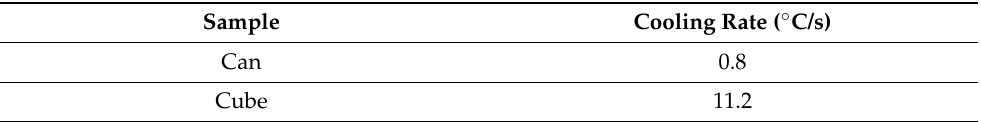
Table 4. Average cooling rate between 1115 °C and 400 °C after solutioning for cube and can HT-A samples.